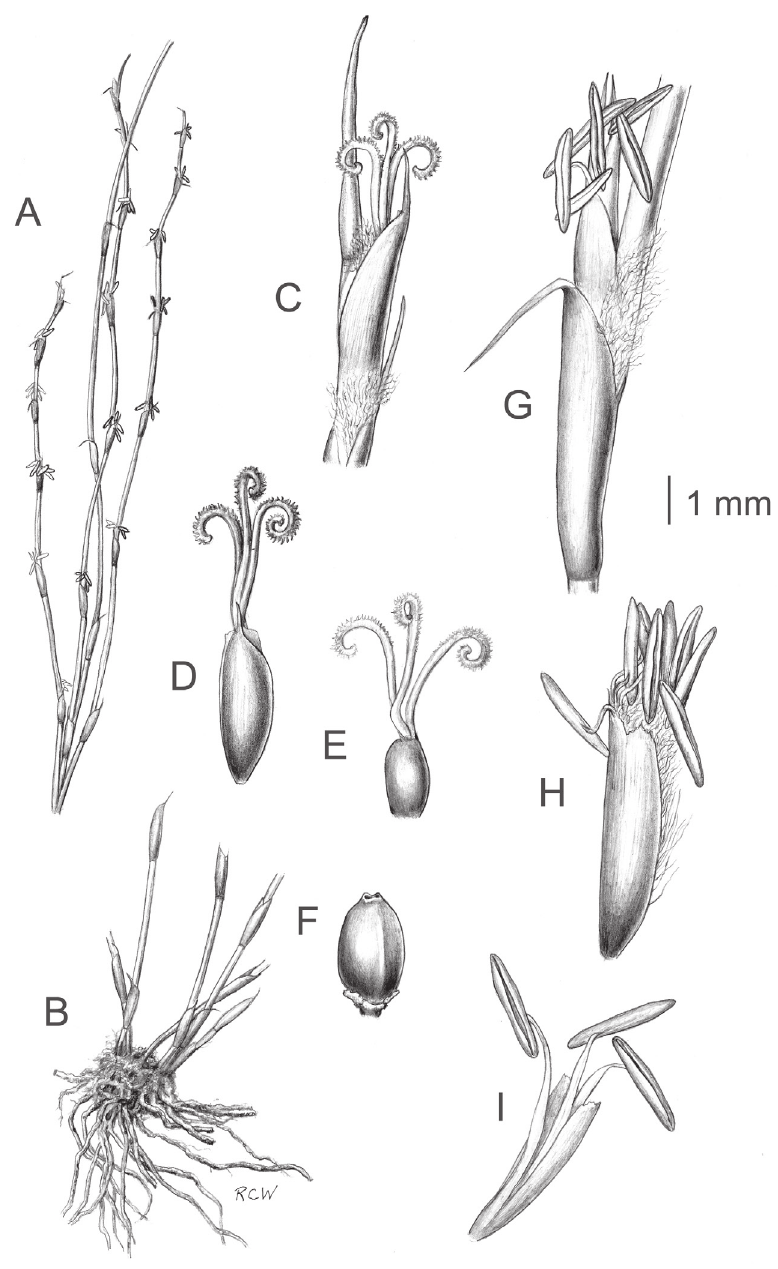
Figure 9. Morphological characteristics of Empodisma robustum . A Vegetative shoot with attached leaves and flowers (actual size) B Rhizomes with emerging vegetative shoots (2.5× actual size) C Vegetative shoot with attached pistillate flower D Pistillate flower with attached bracts e Gynoecium F Mature nut G Vegetative shoot with attached staminate spikelet h Staminate flower with attached bracts i Staminate flower. Scale bar = 1